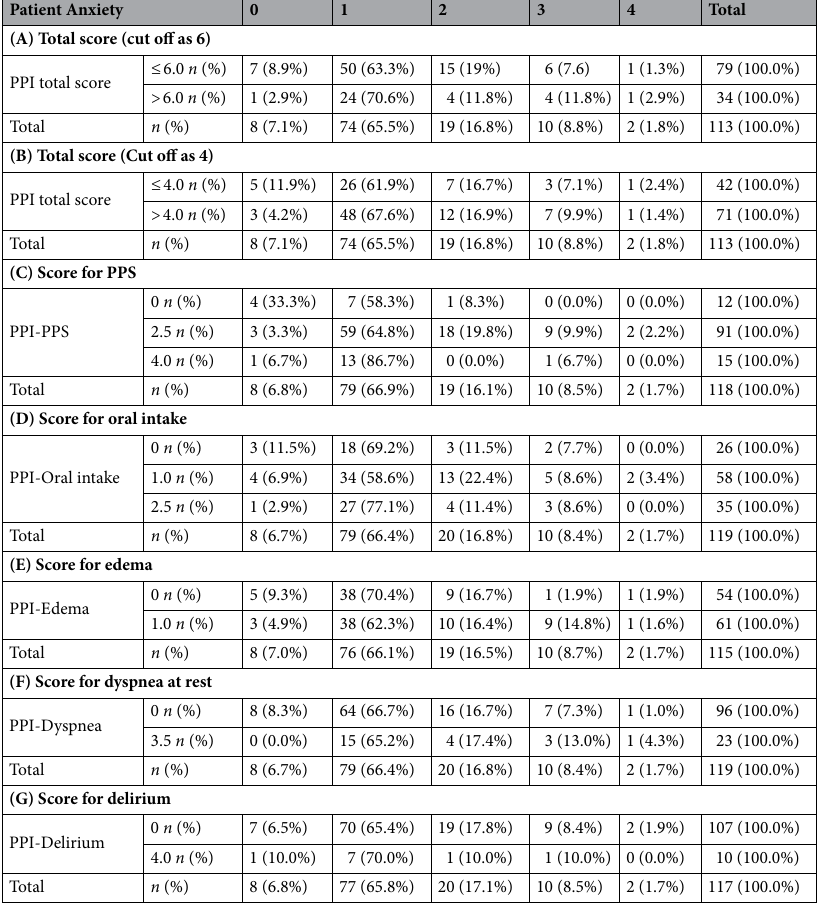
Table 4. Anxiety of patients evaluated with STAS-J and PPI. (A) p = 0.630 (Wilcoxon rank sum test). (B) p = 0.429 (Wilcoxon rank sum test). (C) p = 0.003* (Kruskal–Wallis test). (D) p = 0.274 (Kruskal–Wallis